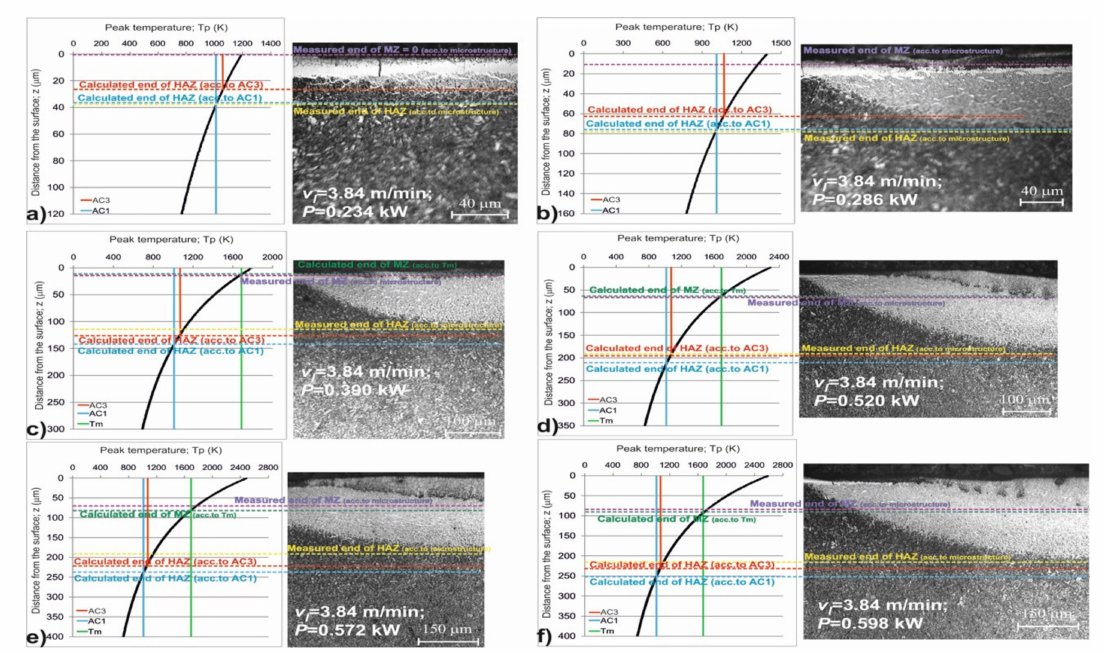
Figure 7. Temperature distribution along the axes of laser tracks and related microstructures after laser modification of gas-nitrided layer using scanning rate v l = 3.84 m · min − 1 and laser beam power as follows: P = 0.234 kW ( a ); P = 0.286 kW ( b ); P = 0.390 kW ( c ); P = 0.520 kW ( d ); P = 0.572 kW; ( e ) and P = 0.598 kW ( f